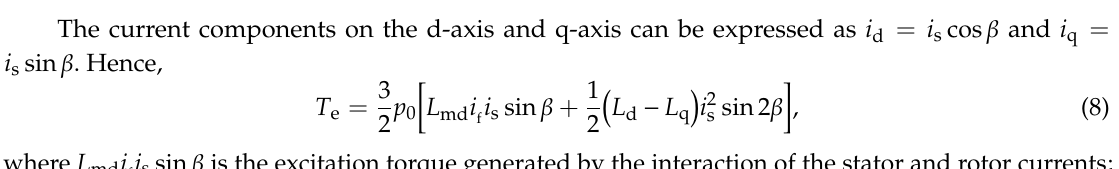
Figure 4. I s in the direct-quadrature (dq) synchronous coordinate system.